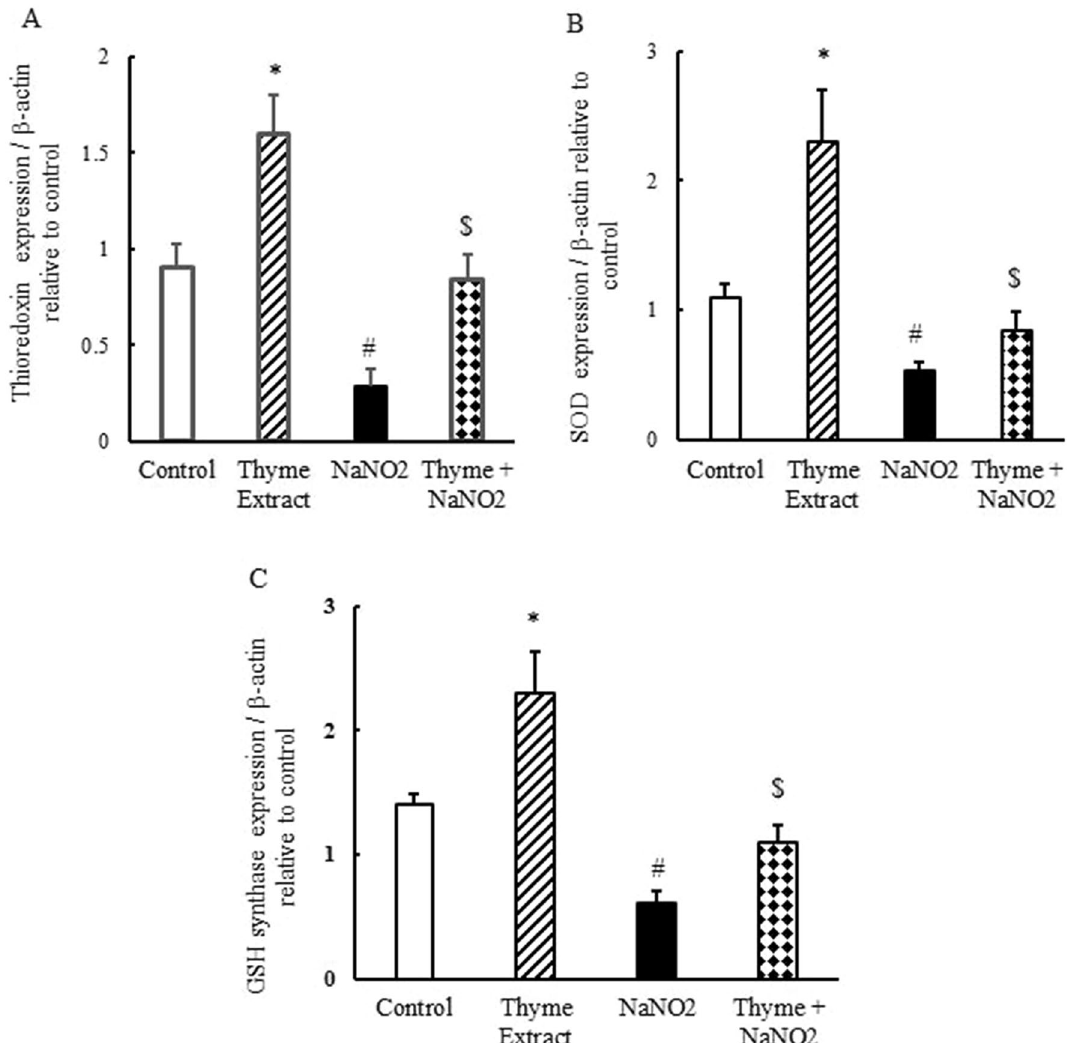
Figure 3. Ameliorative effect of T. vulgaris extract on mRNA expression of thioredoxin ( A ), SOD ( B ), and GSH synthase ( C ) in NaNO 2 -treated mice. Graphic presentation of liver mRNA expression by qRT-PCR analysis of thioredoxin, SOD, and GSH synthase in different groups of mice relative to β-actin. * p < 0.05 versus the control group; # p < 0.05 versus the control and T. vulgaris extract groups; and $ p < 0.05 versus the NaNO 2 -treated